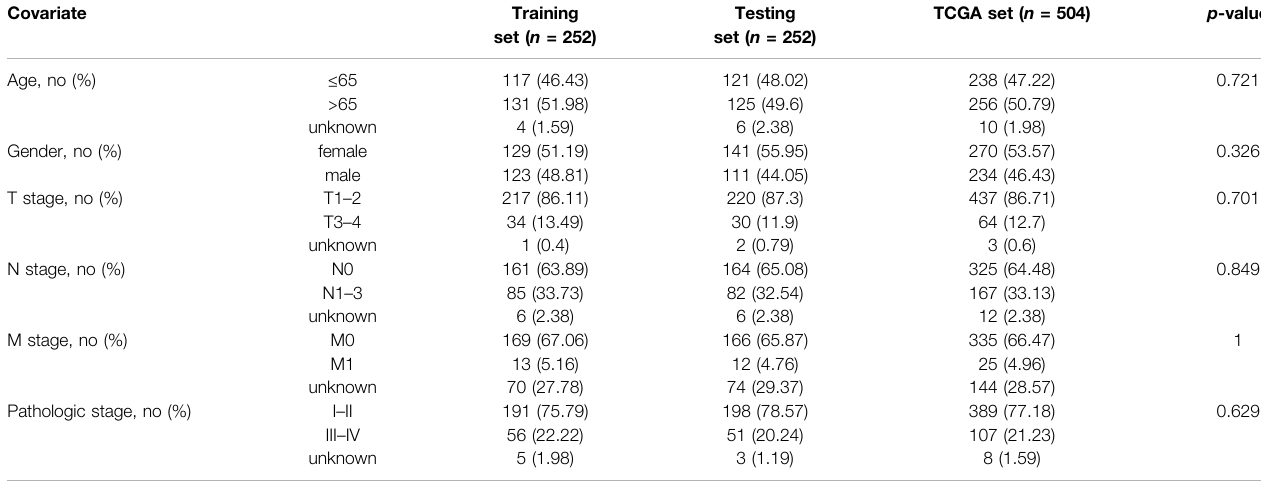
TABLE 1 | Clinical features of the three LUAD patients sets.